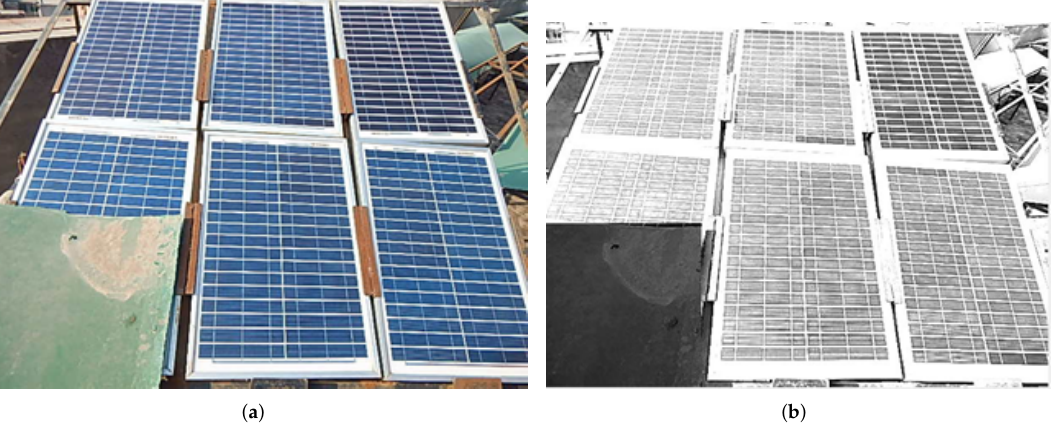
Figure 9. Image processing. ( a ) Partial shading case 2, hardware verification. ( b ) Processed image of case 2 of partial